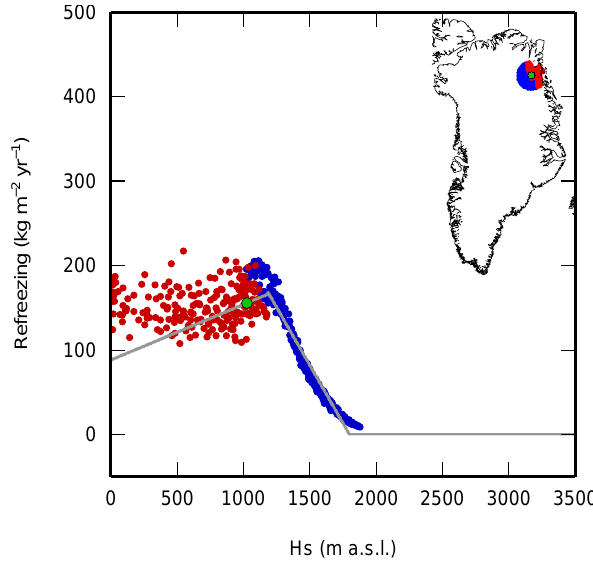
Fig. 7. Parameterization of R as a function of H s . Location of the points are shown in the